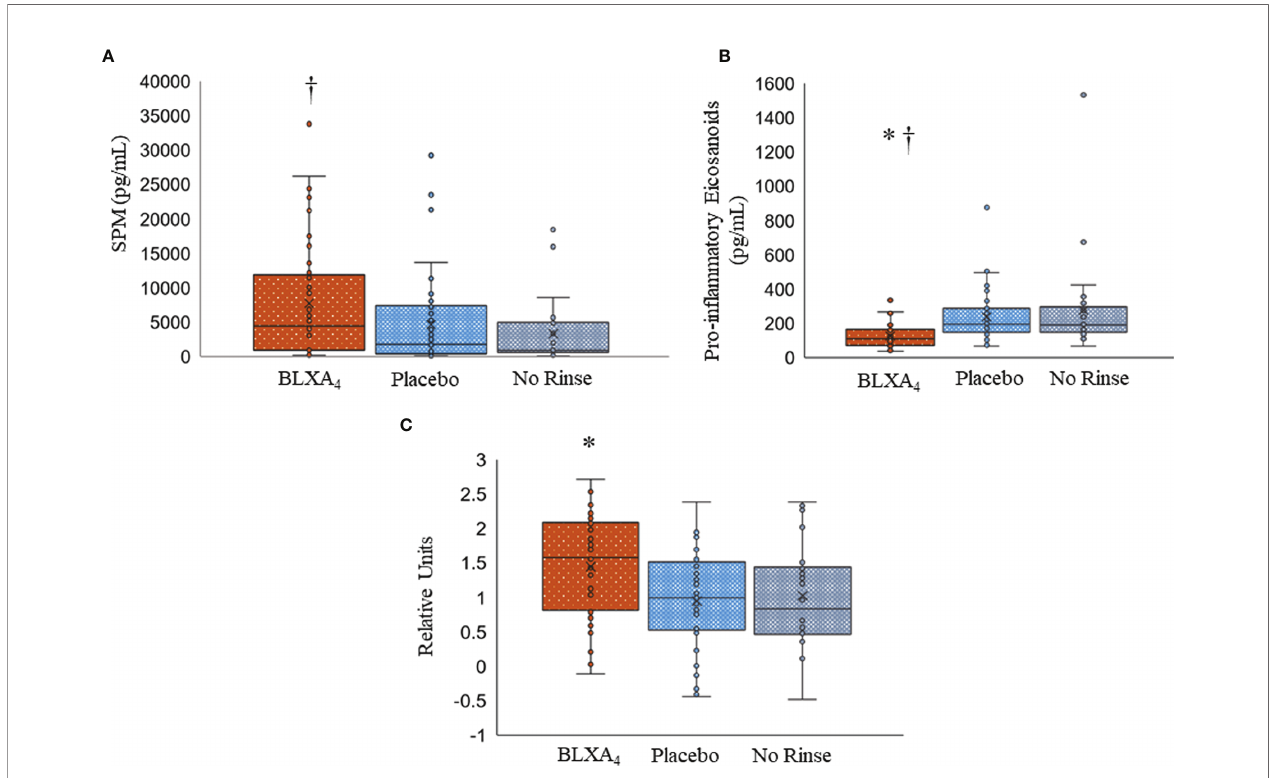
FIGURE 7 | Changes in serum lipid mediator pro fi les by topical BLXA 4 -ME treatment. (A) Sum of pro-resolving mediators (n-3 DHA-derived RvD1-6, PD1, MaR1, MaR2, n-3 EPA-derived RvE1, and AA-derived LXA 4 , LXB 4 ). (B) Sum of proin fl ammatory eicosanoids (AA-derived LTB 4 , PGE 2 and PGD 2 ). Results are means ± 95% con fi dence interval for each subject. (C) Log 10 ratio of pro-resolving mediators (SPMs) to proin fl ammatory eicosanoids, PGD 2 , PGE 2 and LTB 4 (Resolution Index ) . The ratio of pro-resolving lipid mediators to proin fl ammatory eicosanoids at Day 28 was calculated to determine the resolution index after treatment with BLXA 4 . Results are shown as individual results for each patient, horizontal bars depicting median values. Statistical analysis was conducted using one-way ANOVA followed by Tukey post-hoc test. † p<0.05 compared to no rinse; * p<0.05 compared to placebo; N=47 BLXA 4 -treated subjects, N=48 placebo and N=26 no